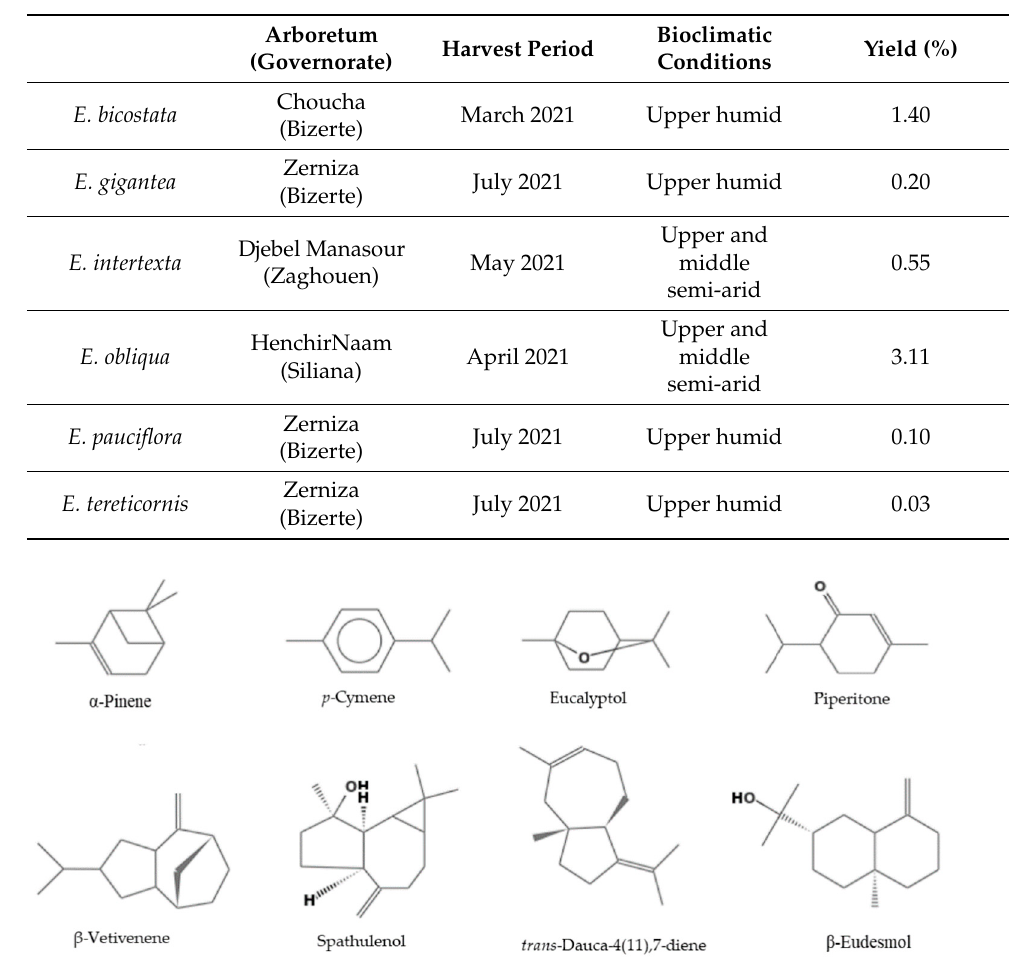
Table 8. Data on plant material, yields, place of origin and climatic conditions.